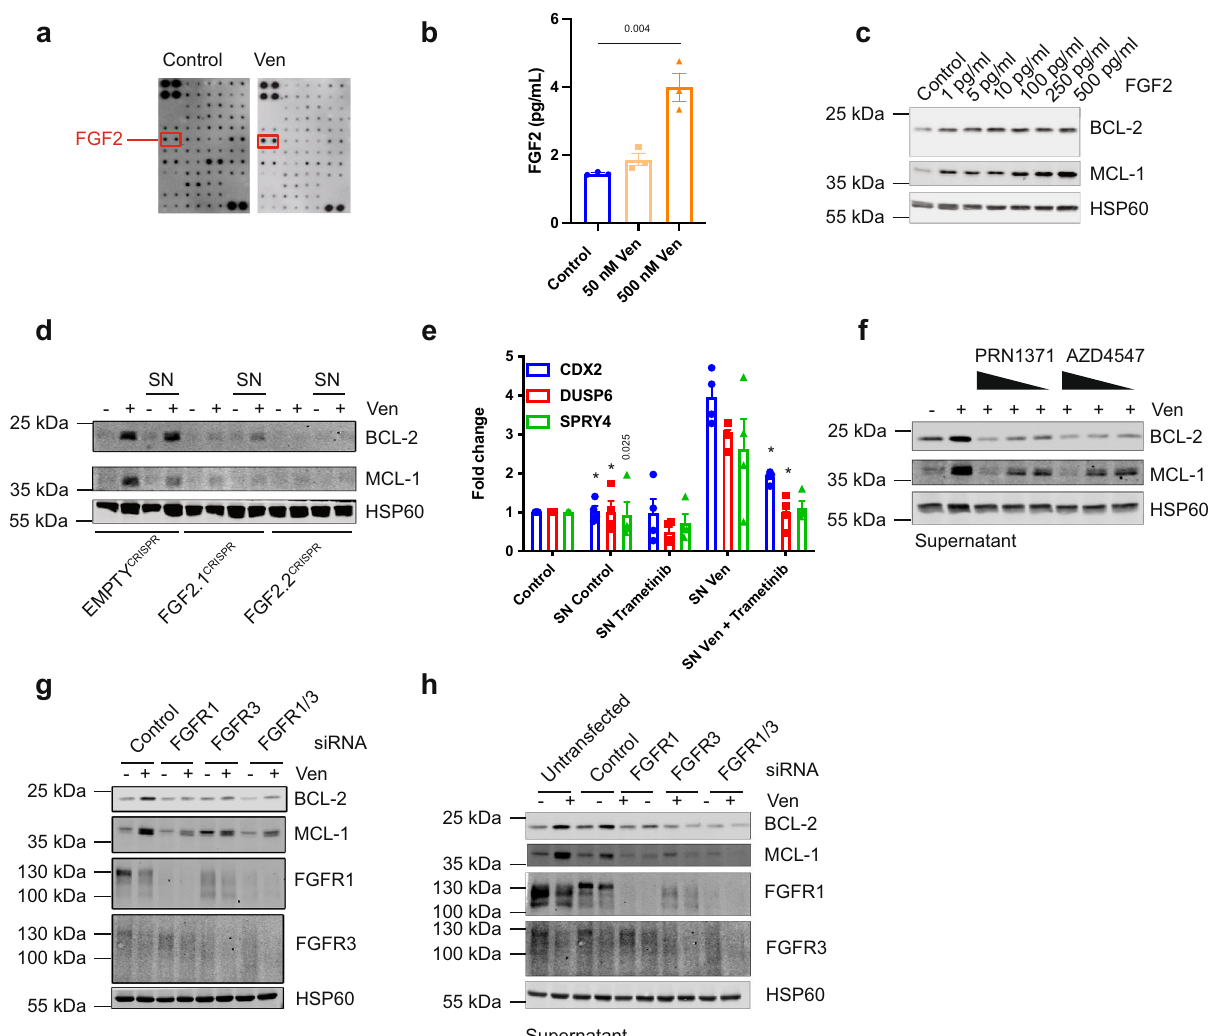
Fig. 4 FGF signalling mediates non-cell autonomous upregulation of BCL-2 proteins. a A growth factor membrane ligand array was probed with supernatant from control or venetoclax treated HeLa tBID2A cells. Spots for FGF2 are indicated. b Levels of FGF2 were determined in supernatant from control or venetoclax treated HeLa tBID2A cells by ELISA. n = 3 independent experiments; mean values ± s.e.m.; unpaired, two-sided t -test. c HeLa tBID2A cells were treated with recombinant FGF2, harvested after 6 h and protein expression analysed by western blot (representative blot of three independent repeats). d Control or FGF2 CRISPR HeLa tBID2A cells were directly treated with venetoclax or the respective supernatant for 48 h as indicated before harvesting and analysis of protein expression by western blot (representative blot of three independent repeats). e Supernatant from untreated